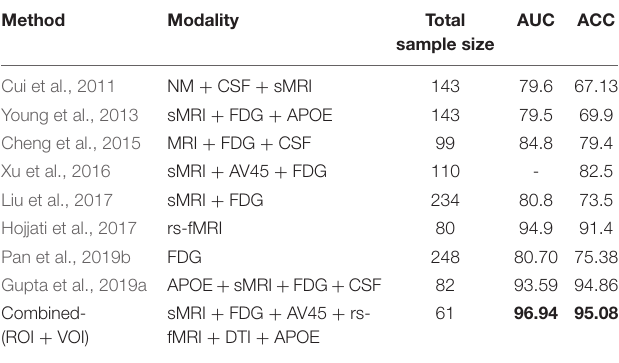
TABLE 6 | Performance comparison for MCIs vs. MCIc classification